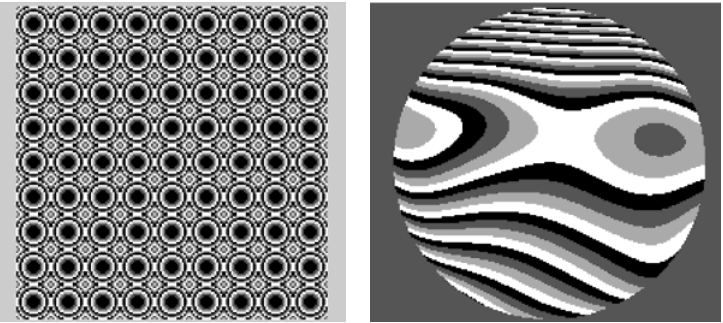
Figure 2. Grayscale representation of the four-level VPTNLC patterns: (left) for generating a 9 x 9 diffractive microlens array; (right) for compensating the aberration produced by an artificial eye.